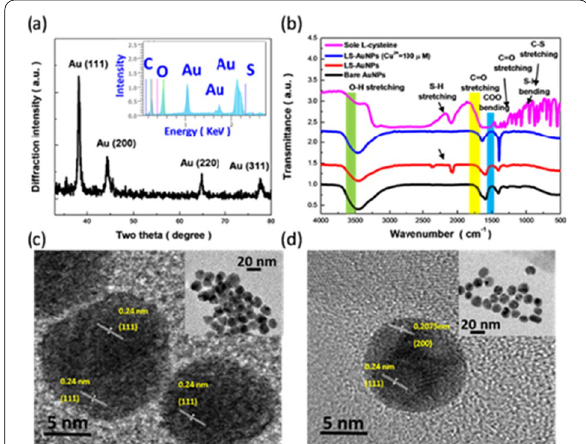
Fig. 1 a XRD result of LS‑AuNPs. Correlated EDS result was shown in the inset of Fig. 1a. b FTIR result and TEM images of LS‑AuNP probes c before and d after sensing Cu 2 + ions (50